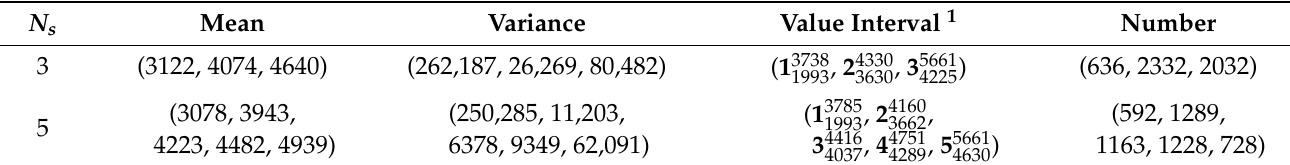
Table 2. Analysis of torque by